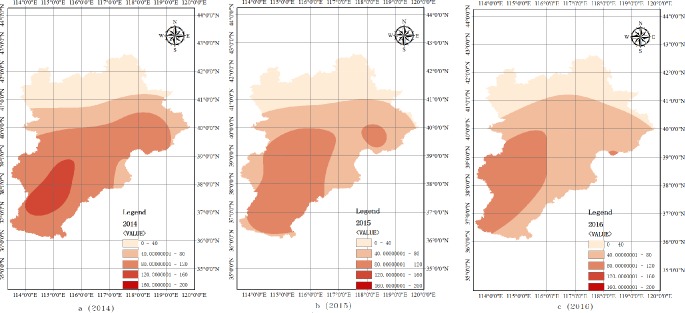
Spatial variation of PM2.5 concentration in 2014, 2015 and 2016 (a, b and c) (Unit: μg/m3).